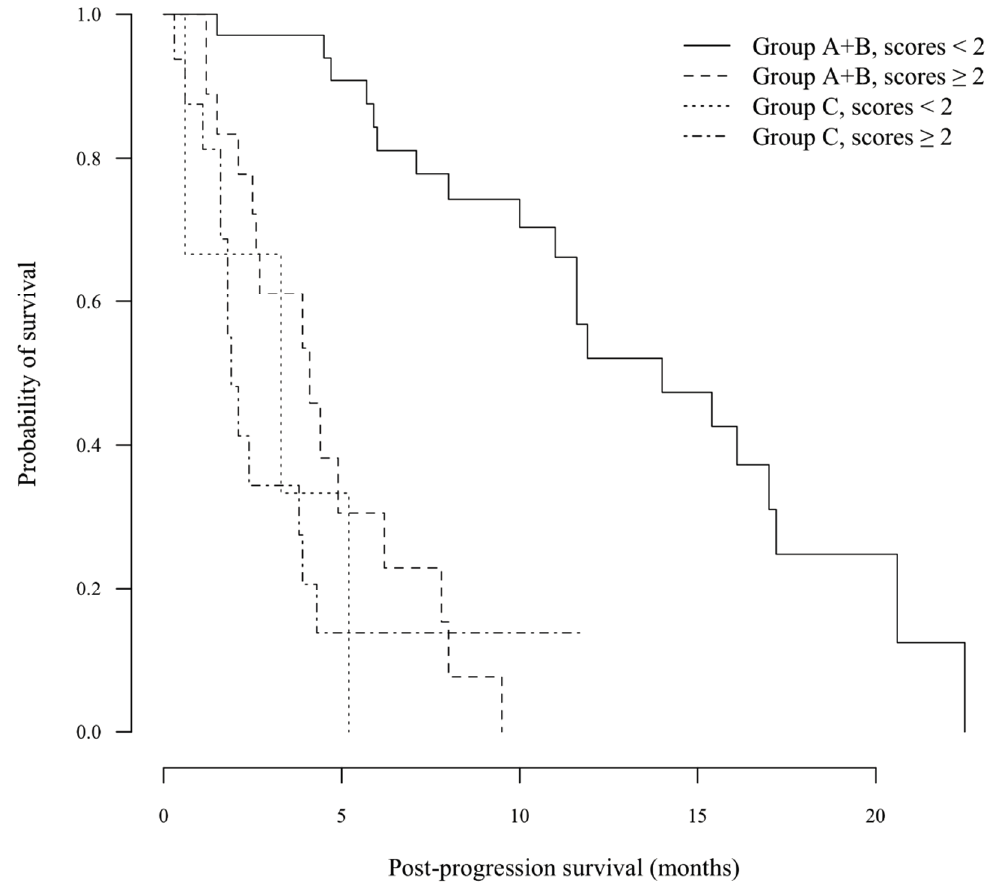
Figure 1. Kaplan–Meier analysis of post-progression survival (PPS). In patients with scores ≥ 2 points, no statistically-significant difference in PPS was observed between the A + B and C groups (median 4.1 vs. 1.9 months, respectively; p = 0.220). In contrast, the PPS of Group A + B was significantly longer than that of Group C in patients with scores <2 points (median 14.0 vs. 3.3 months, respectively; p <